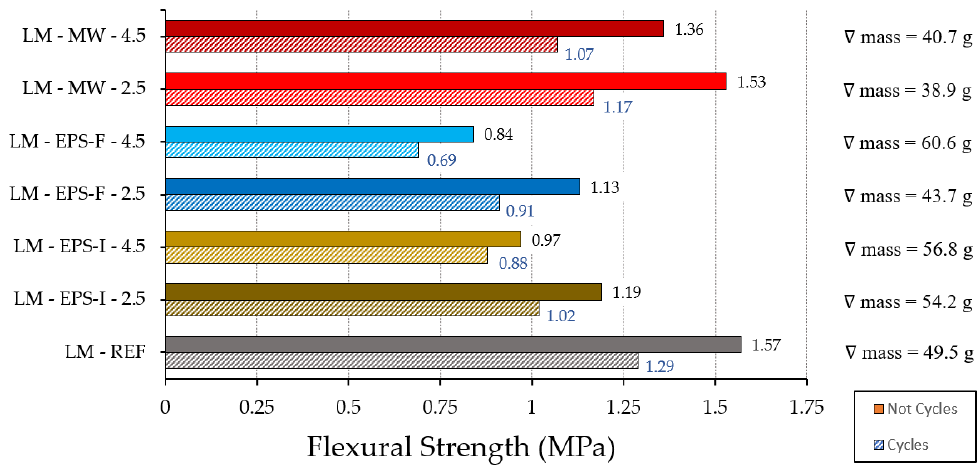
Figure 12. Results of the salt crystallization test. Flexural strength of cycled samples (scratched stripes) and reference samples (solid stripes), including loss of mass.